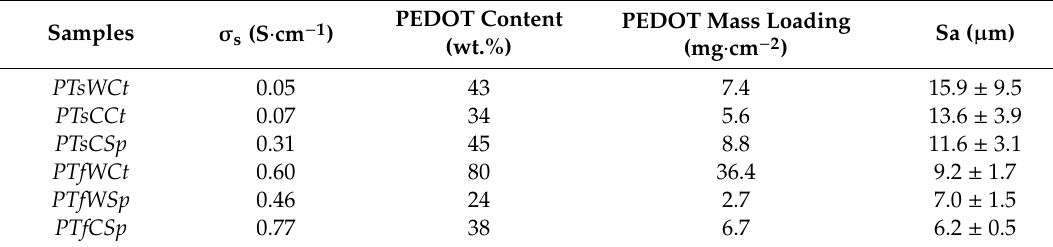
Table 4. Surface conductivities, polymer content, mass loading and roughness values for in-situ prepared composite materials.